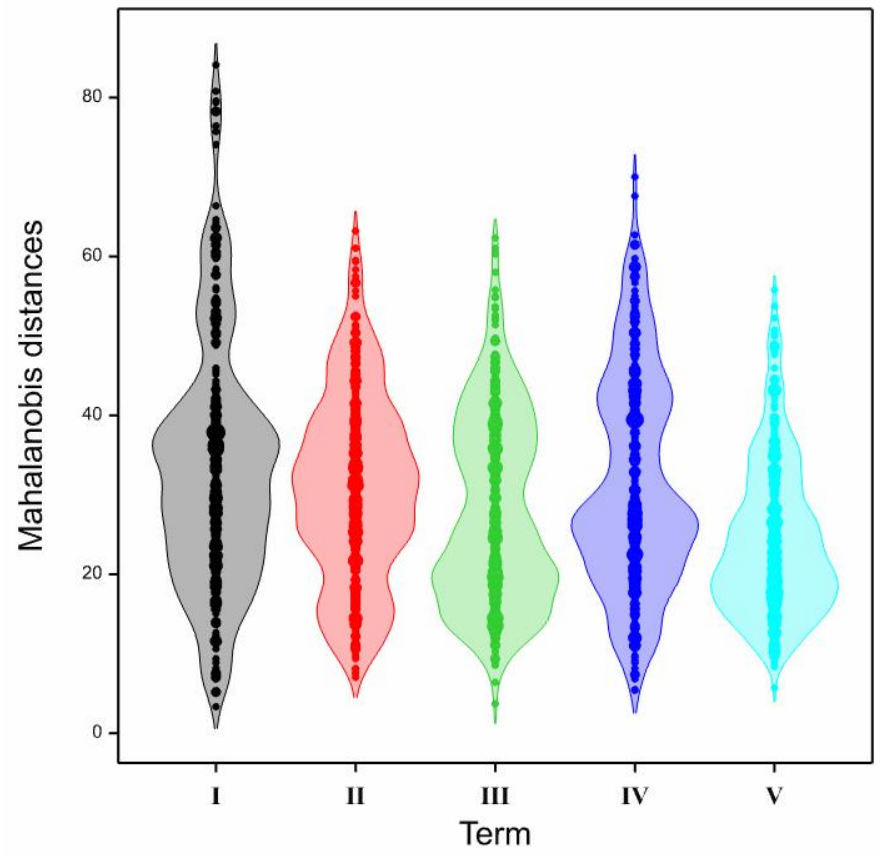
Figure 7. Density of Mahalanobis distance at the five terms: I—1st term—pre-sowing, II—2nd term—tillering phase (BBCH 23), III—3rd term—second node (BBCH 32), IV—4th term—heading (BBCH 55), and V—5th term—post-harvest.